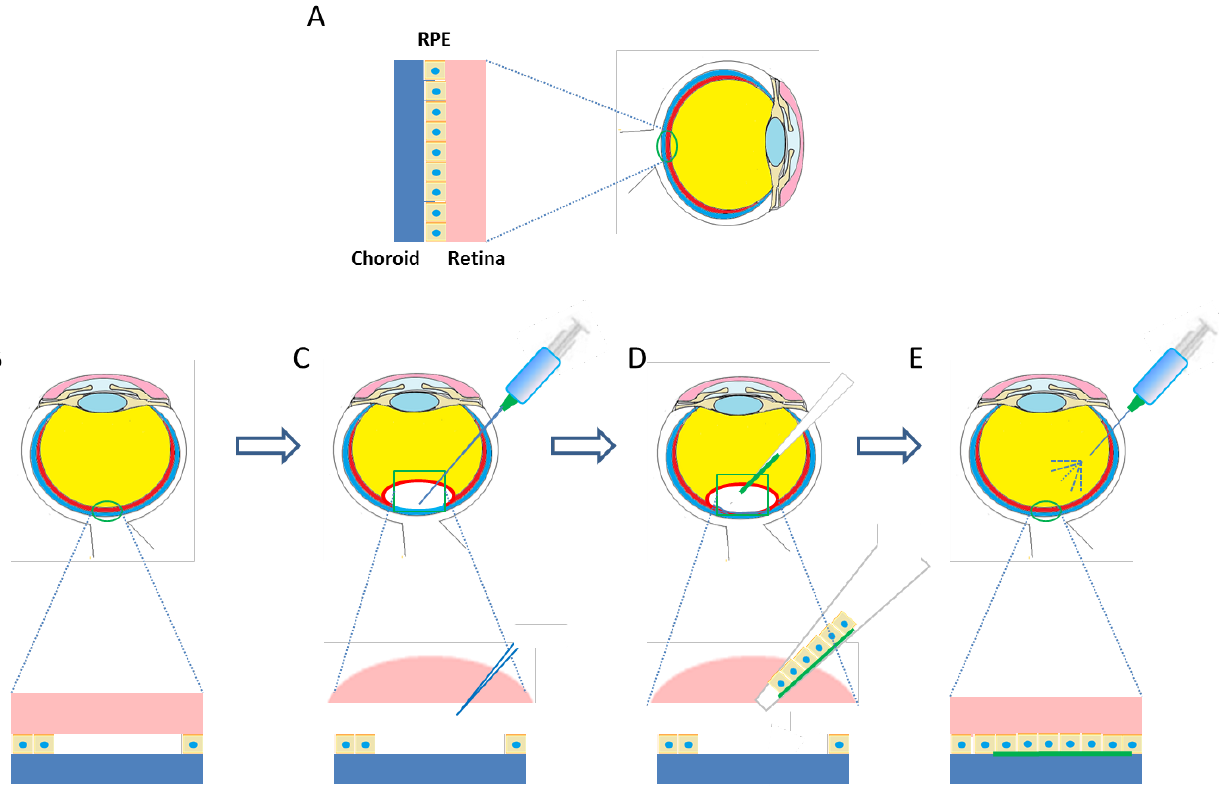
Figure 4. Potential treatment of RPE degeneration with RPE sheet-gelatin